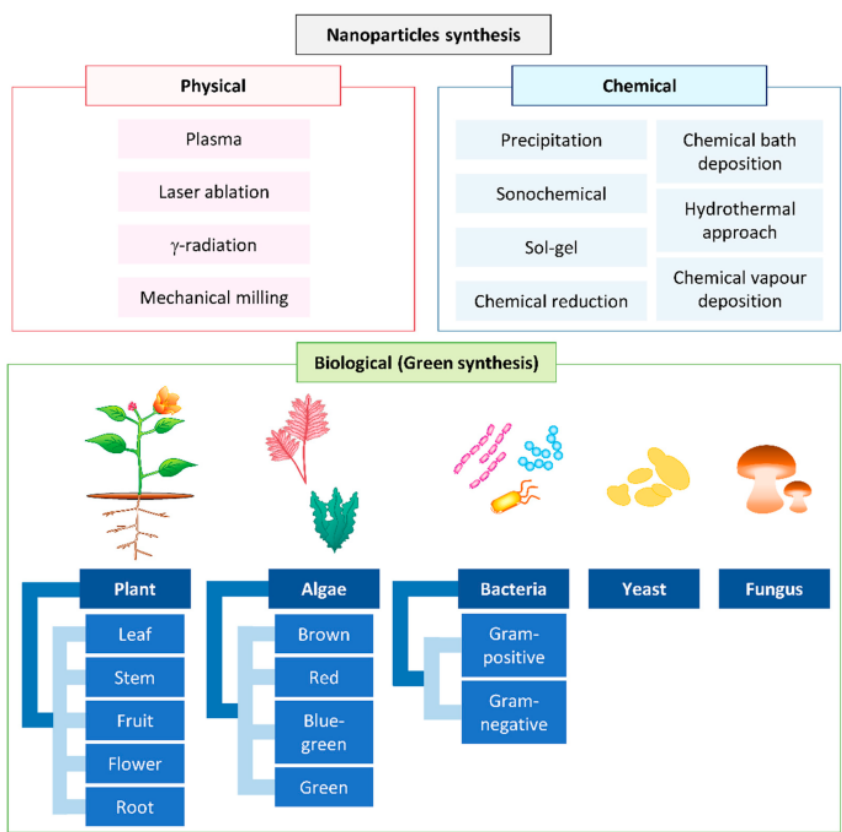
Figure 1. Different approaches used for the synthesis of nanoparticles. Copied from MDPI [17]. Additionally, the biological method, which is a bottom-up approach, synthesizes NMs using biopolymers, biomolecules, viruses, bacteria, yeasts, plants, and fungi [18]. Figure 2 shows the difference between the two methods used for the synthesis of NMs (bottom-up and top-down). Table 1 summarizes the advantages and disadvantages of the different approaches used for the synthesis of